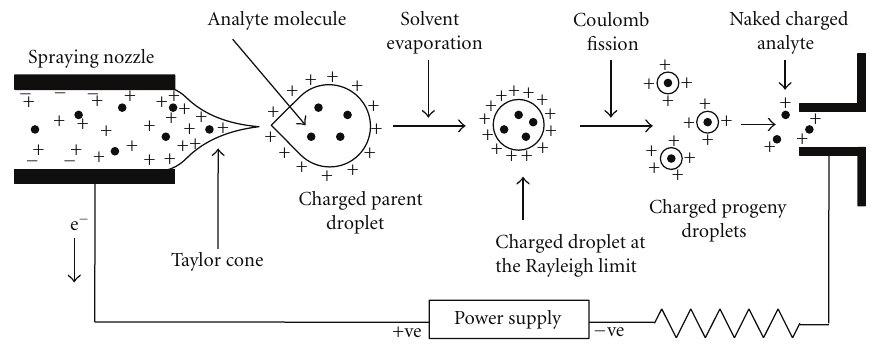
Figure 6: Schematic representation of the electrospray ionization